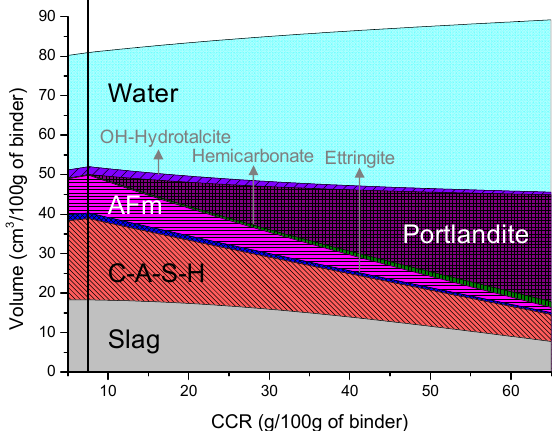
Figure 5. Calculated phase composition of the mixtures of slag and CCR.